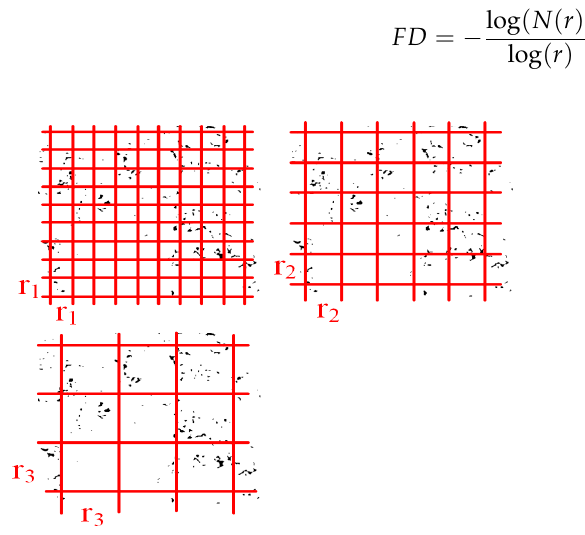
Figure 6. Images of box arrays of different sizes (r).